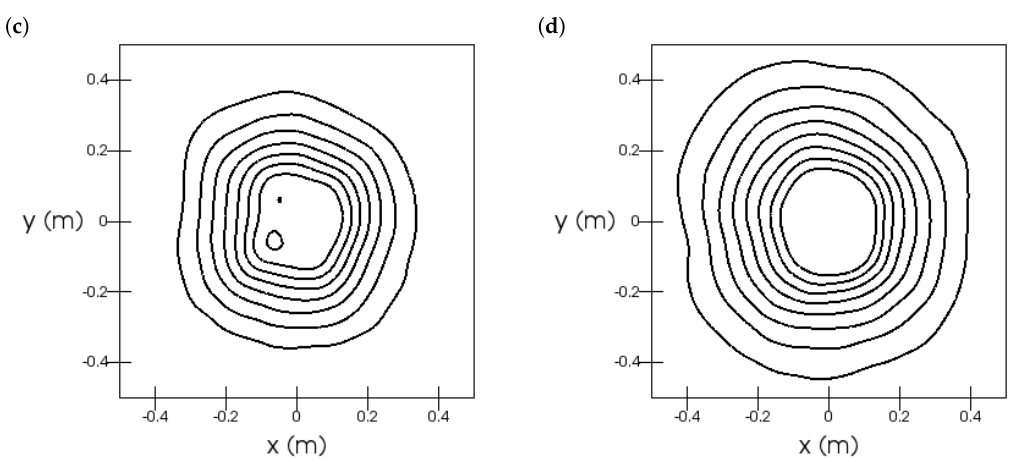
Figure 15. Sandia flame, Test 24: iso-contours of axial velocity. The sub-figures are at heights z = 0.1m ( a ), z = 0.3m ( b ), z = 0.5m ( c ), and z = 0.9m ( d ). The contours are in the range [ 0.5,4 ] ms − 1 with a stride of 0.5ms − 1 .